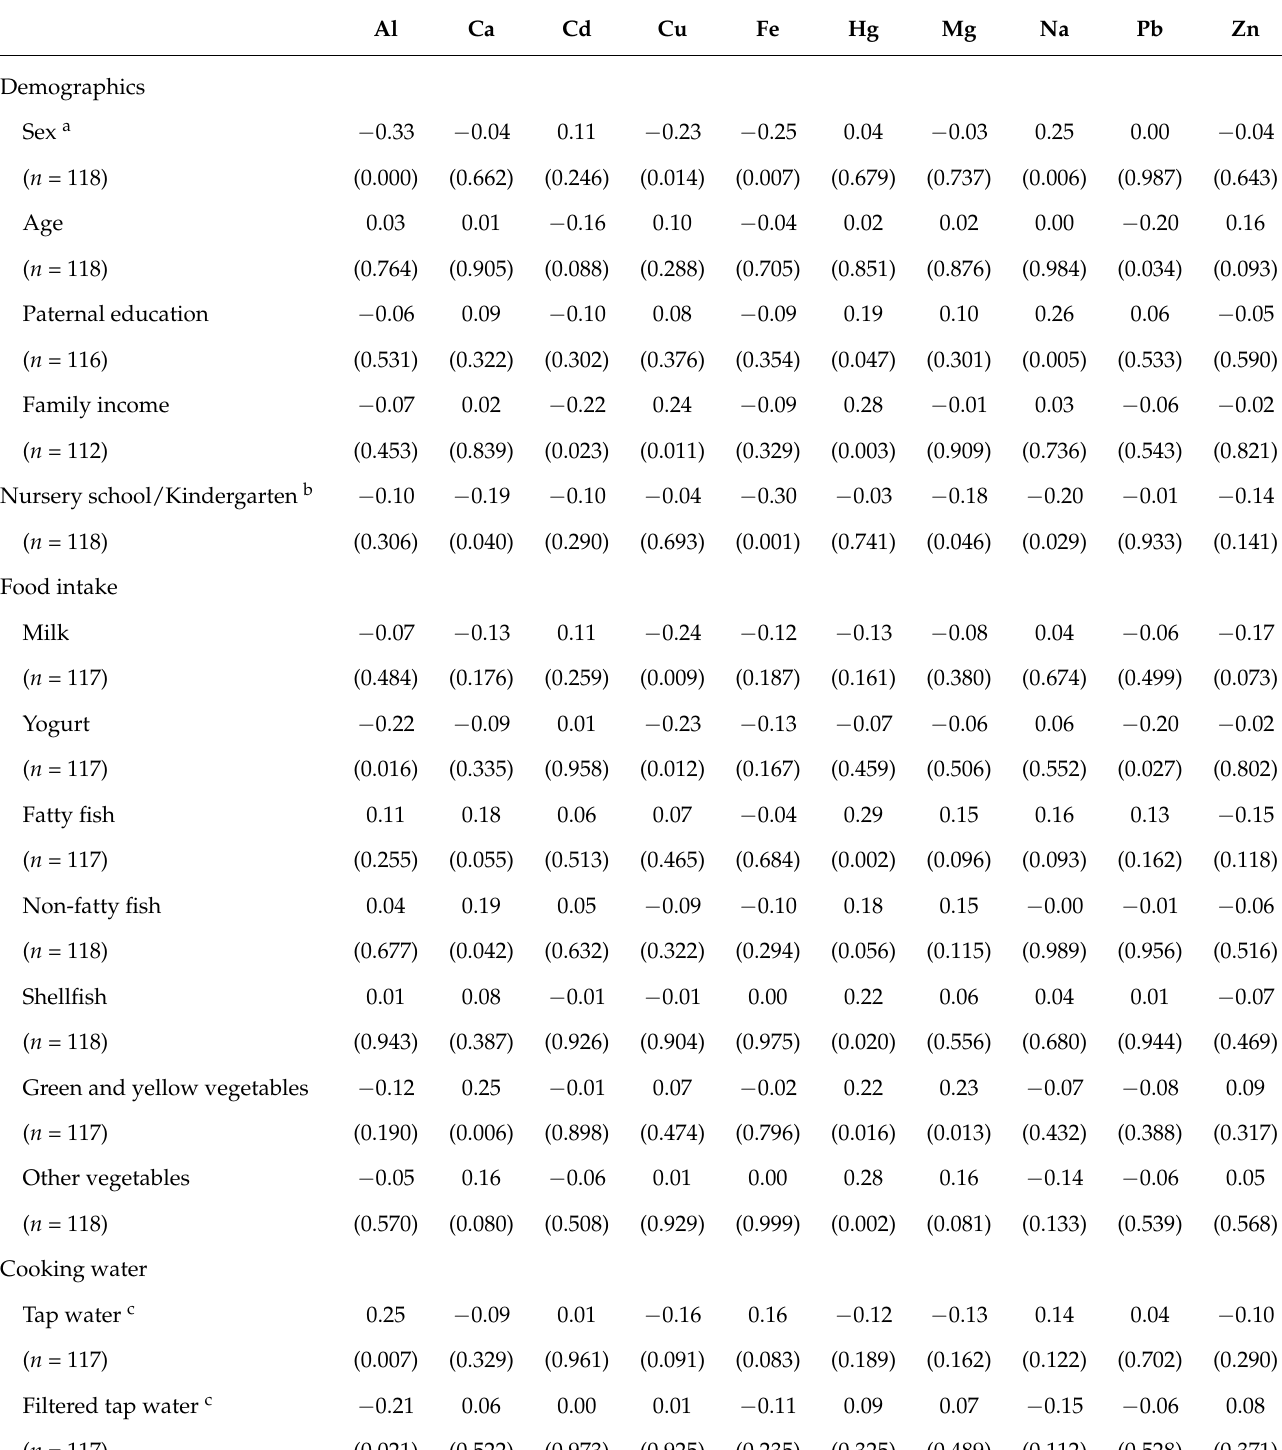
Table 4. Pearson correlations between log-transformed hair elements’ concentrations and demo- graphic and food and water consumption ( p values in